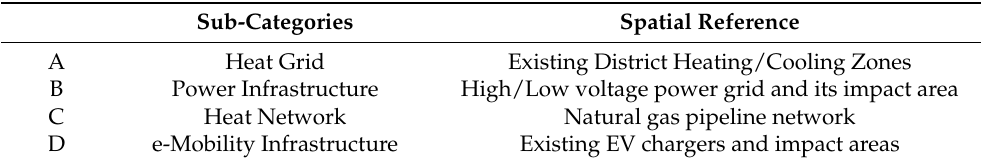
Table 4. Category 4: Physical infrastructure.